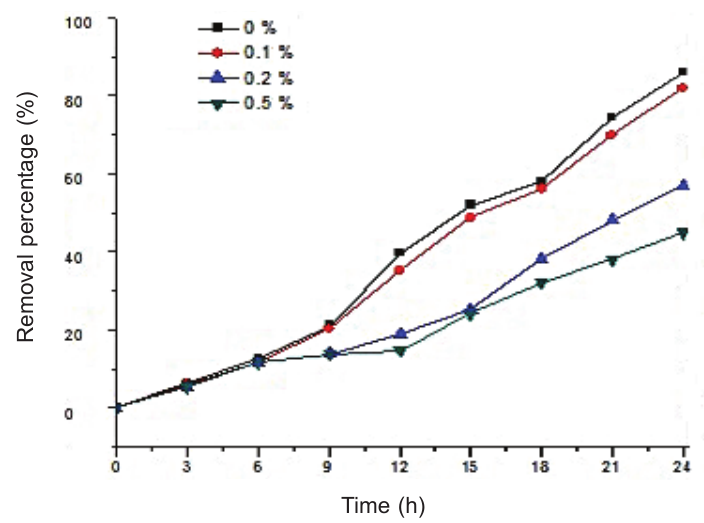
Fig. 7 – Effect of glucose on the phenol degradation of strain